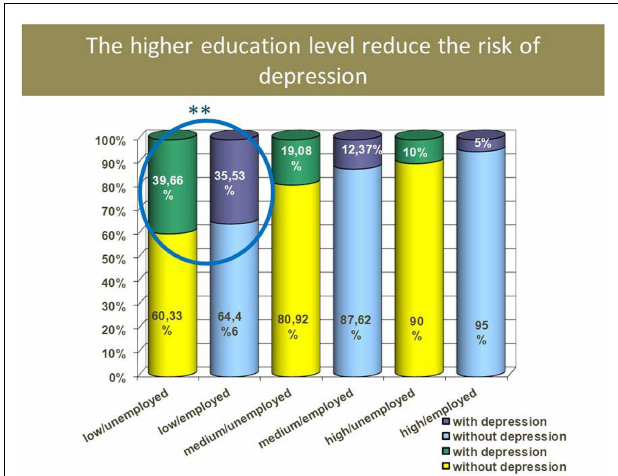
FIGURE 6 | Depression rate and educational level